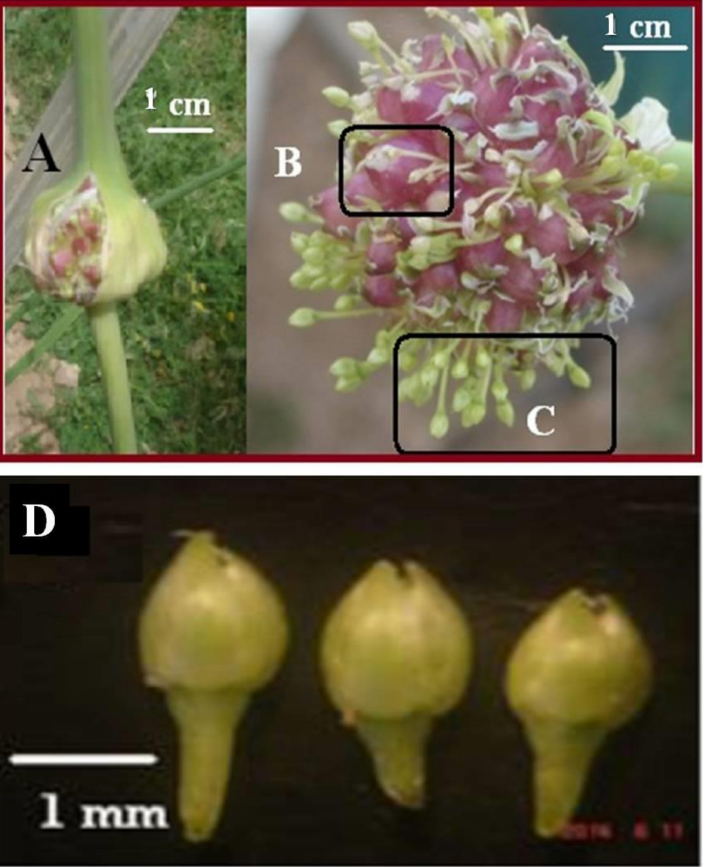
Figure 2. ( A ) Composite flowers of garlic, ( B ) aerial bulb, ( C ) barren florets of garlic, and ( D ) garlic flower